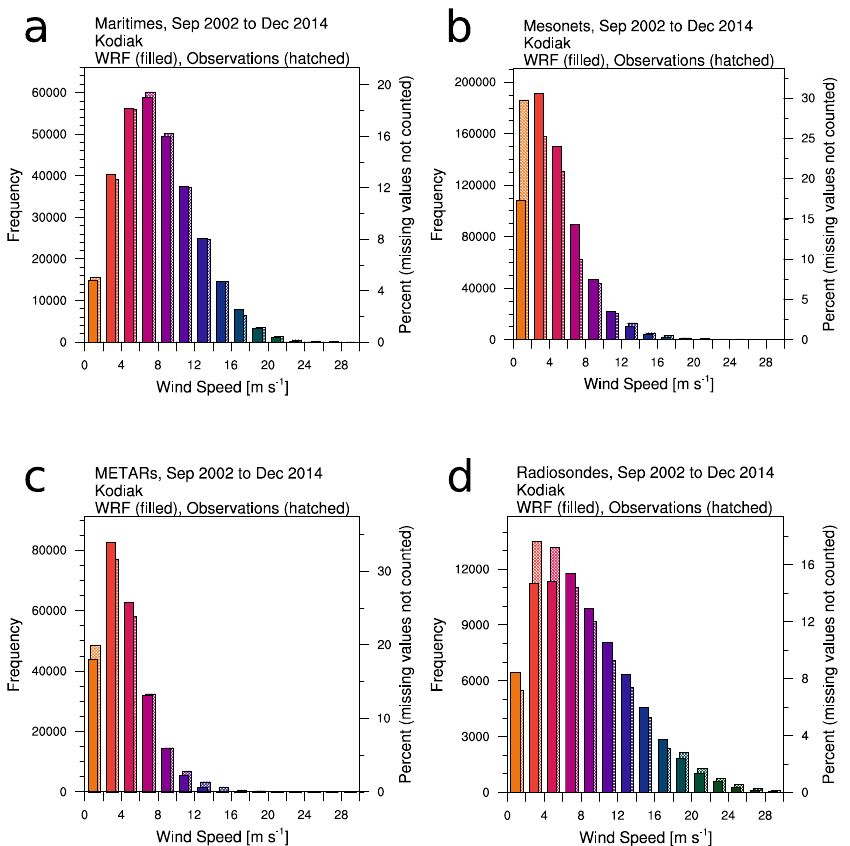
Figure 14. Binned histograms of wind speed from the WRF model (solid filled bars) and observations (hatched/stippled bars) in the Kodiak region, for the ( a ) maritime, ( b ) mesonet, ( c ) METAR, and ( d ) radiosonde networks, spanning Sep September 2002–December 2014. The bin width is 2 m s − 1 .